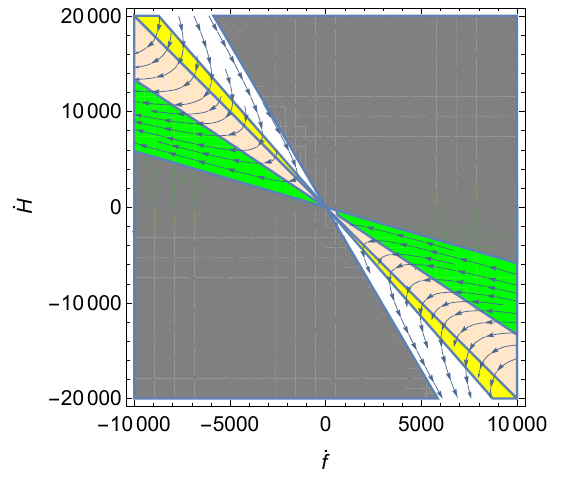
Figure 1 . The (cid:13)ow of solutions with ~ (cid:16) = 1 : white ( (cid:127) f > 0, (cid:127) a < 0 , (cid:127) H < 0) , yellow ( (cid:127) f < 0, (cid:127) a < 0 , (cid:127) H < 0) , light orange ( (cid:127) f < 0, (cid:127) a > 0 , (cid:127) H < 0), green ( (cid:127) f < 0, (cid:127) a > 0 , (cid:127) H >